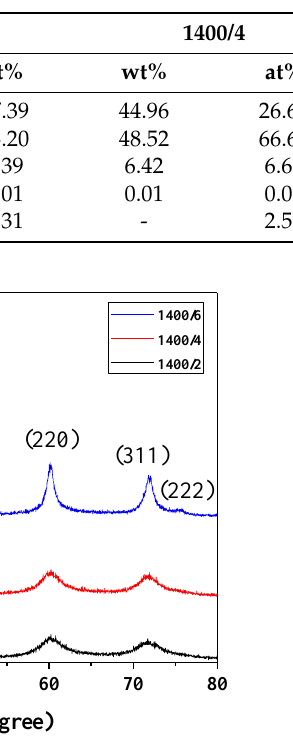
Figure 3. SEM-EDS images of the polymer-derived SiC fibers fabricated at 1400 ◦ C for ( a ) 2, ( b ) 4, and ( c ) 6 h. Table 1 exhibits the tendency of the element content in the amorphous SiC fiber pre- Table 1. EDS mapping of amorphous SiC fiber depending on the heat treatment time.